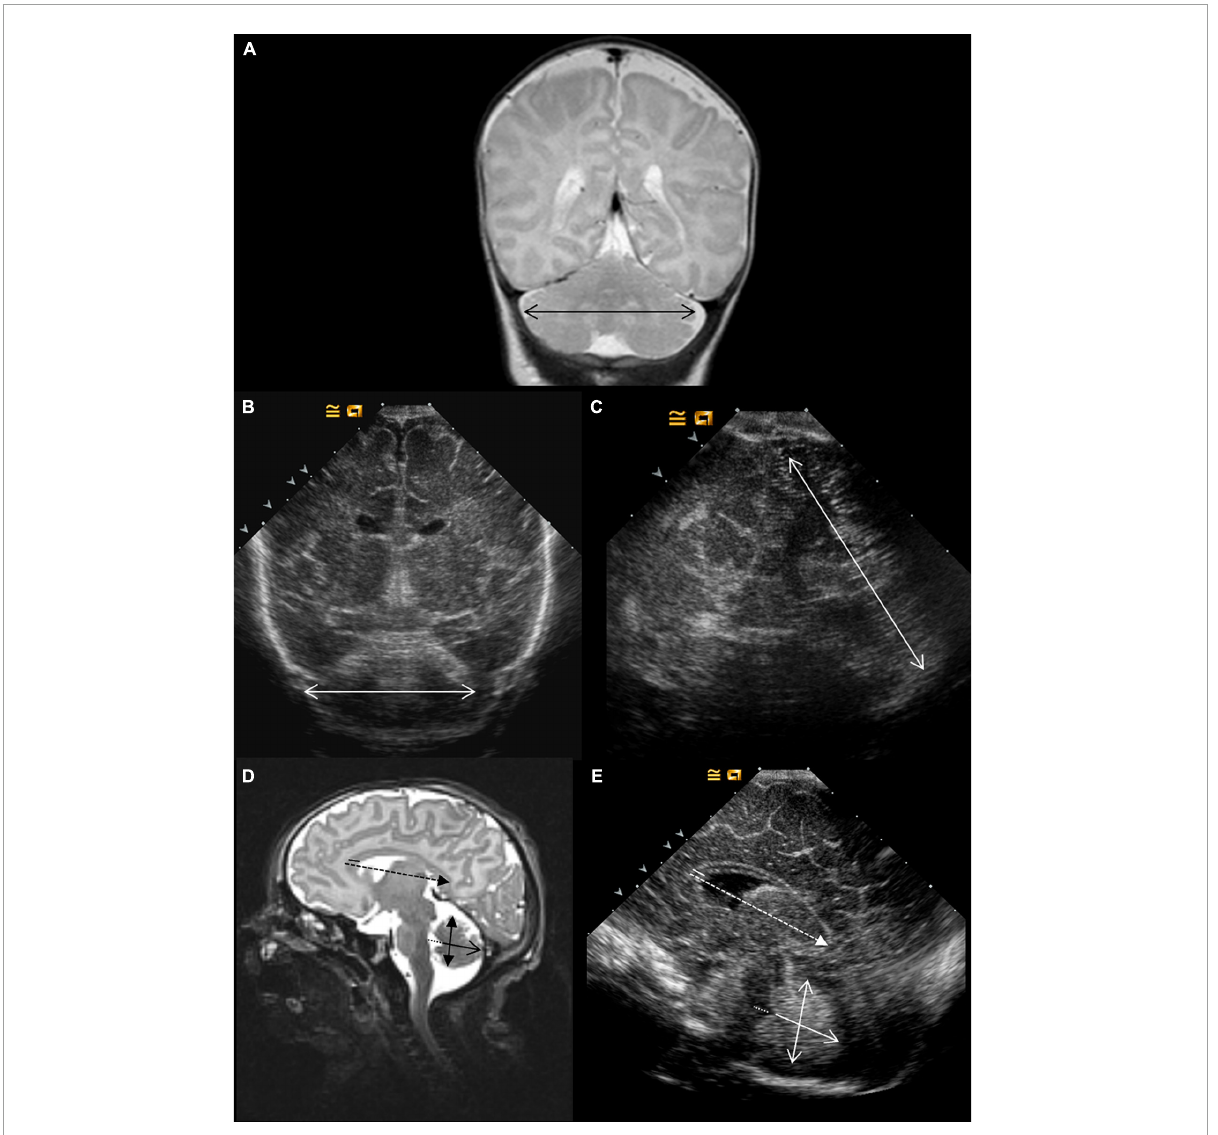
FIGURE2 Imaging metric protocol. Coronal and sagittal views. On T2-weighted MRI, the transcerebellar diameter is measured on a coronal view (A) . Two acoustic windows were compared on ultrasound: coronal (B) and mastoid planes (C) . On T2-weighted MRI (D) and ultrasound, sagittal view (E) were assessed the corpus callosum length (discontinued arrow) and width (plain line), the anteroposterior vermis diameter (plain arrow) and height (double head arrow), and the fourth ventricle diameter (discontinued